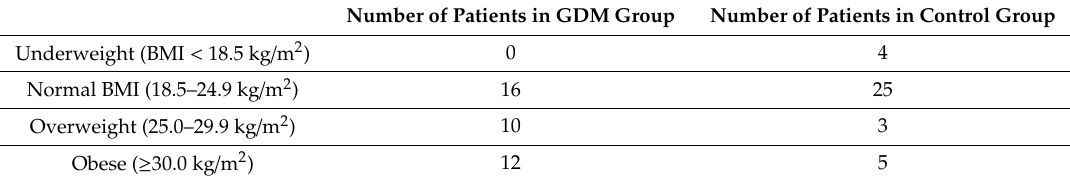
Table 3. Number of GDM and control subjects per BMI group